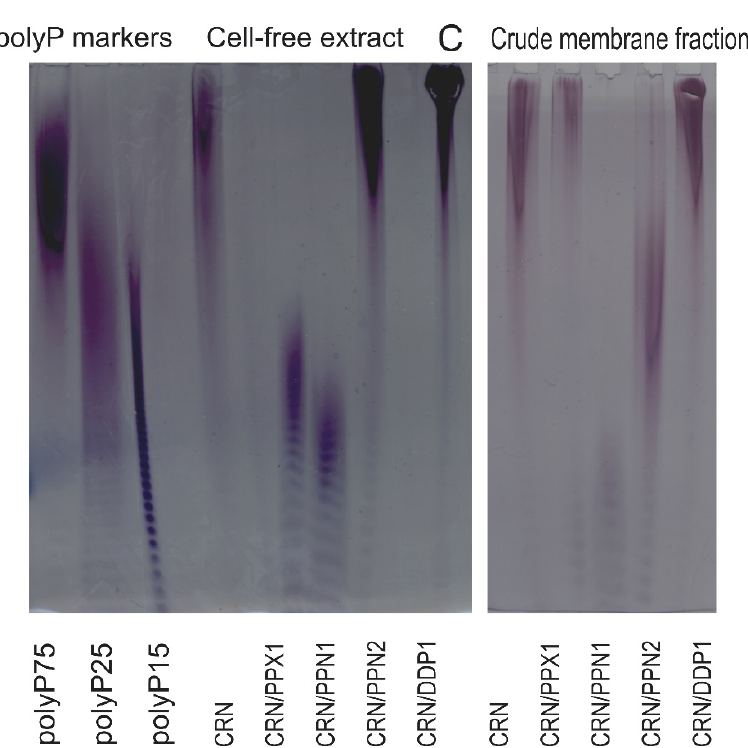
Figure 3. Decrease in chain length of polyP 208 (commercial preparation of polyP with average chain length of 208 phosphate residues) after incubation with cell-free extract or crude membrane fraction samples obtained from cells of S. cerevisiae strains overexpressing polyphosphatases Ppx1, Ppn1, Ppn2, or Ddp1, and parent strain CRN. Incubation medium contained 50 mM Tris-HCl, pH 7.2, 200 mM NH 4 Cl, 1 mM MgSO 4 , 9 mM polyP 208 and cell-free extract or crude membrane fraction samples. Amounts of total protein added to reaction mixture were 157, 90, 60, 59, and 63 µ g for cell-free extracts preparations from cells of CRN, CRN/PPX1, CRN/PPN1, CRN/PPN1, and CRN/DDP1 strains, respectively. Amounts of total protein added to reaction mixture were 61, 55, 14, 16, and 60 µ g for crude membrane preparations from cells of CRN, CRN/PPX1, CRN/PPN1, CRN/PPN1, and CRN/DDP1 strains, respectively. C-control, polyP 208 was incubated without polyphosphatase- containing samples. PolyP markers were from Sigma-Aldrich (polyP 75 , polyP 25 , and polyP 15 were polyP with average chain length of 75, 25 and 15 phosphate residues, respectively. Electrophoresis was performed in 30% PAAG with 7 M urea, staining with toluidine blue. A pixel densitometry graph of electrophoregrams is shown in Supplementary Figure